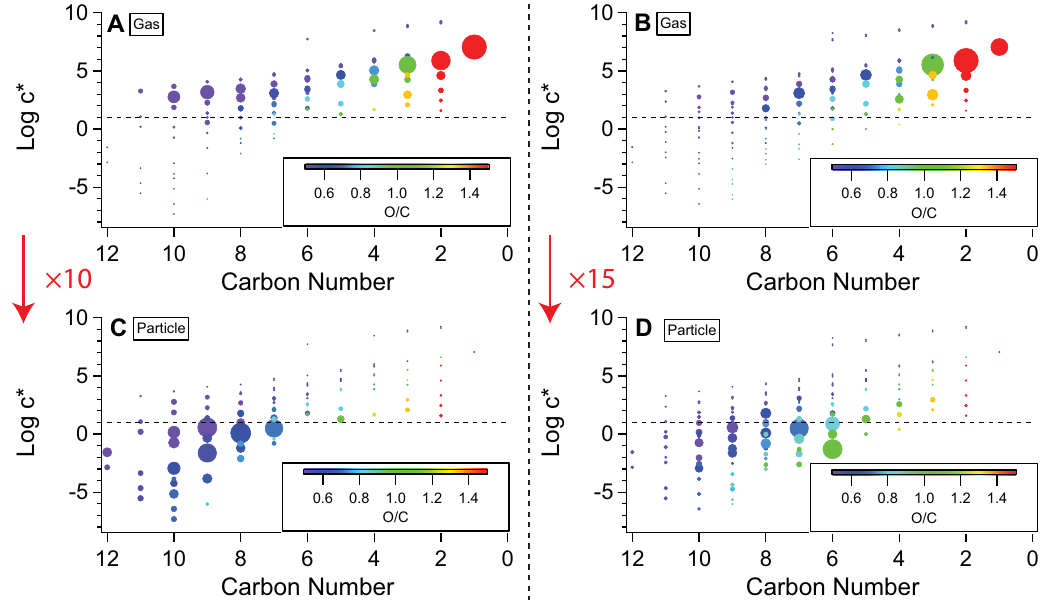
Figure 5. Estimated log c ∗ as a function of carbon number and O / C. (a) and (c) represent extracted gas and particle spectra of α -pinene ozonolysis (Expt 1), respectively, and (b) and (d) represent the same of α -pinene photooxidation at high OH exposures (Expt 7). Marker area is proportional to the fraction of mass in the depicted spectra. The factor and arrow in red represents the relative mass scale between gas and particle spectra. For example × 10 between (a) and (c) indicate that markers of equal area represent the same fraction in each phase and 10 times more mass in the gas-phase